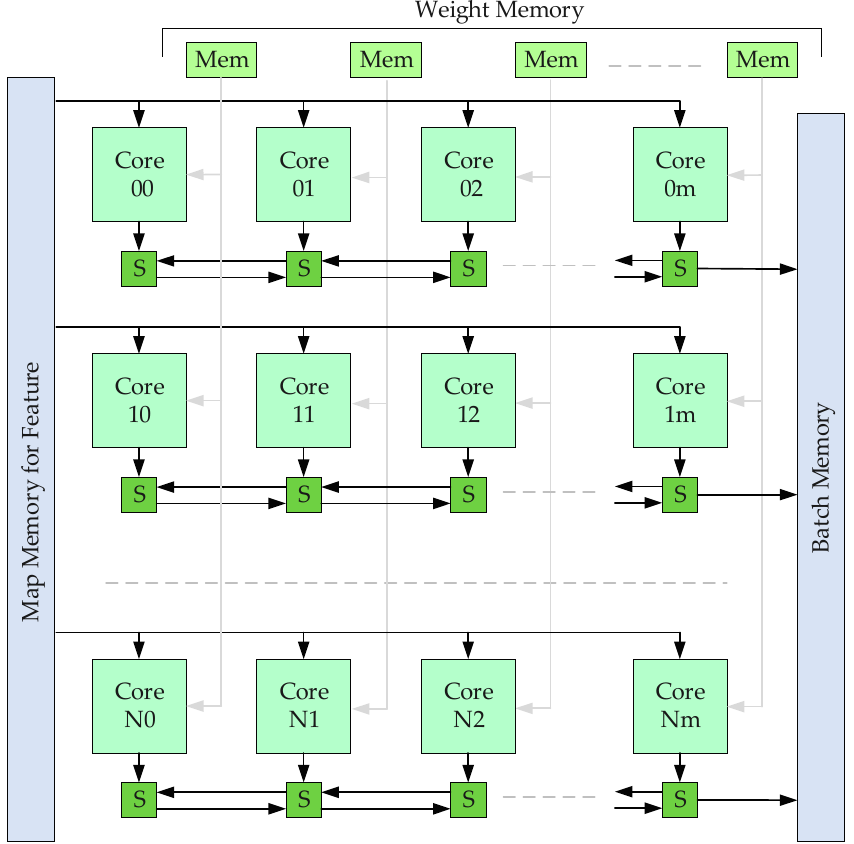
Figure 1. Interconnection between PE (processing element) and S (switch).